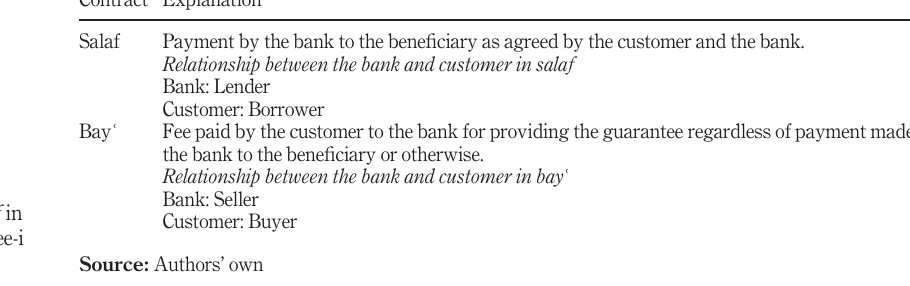
bank guarantee-i